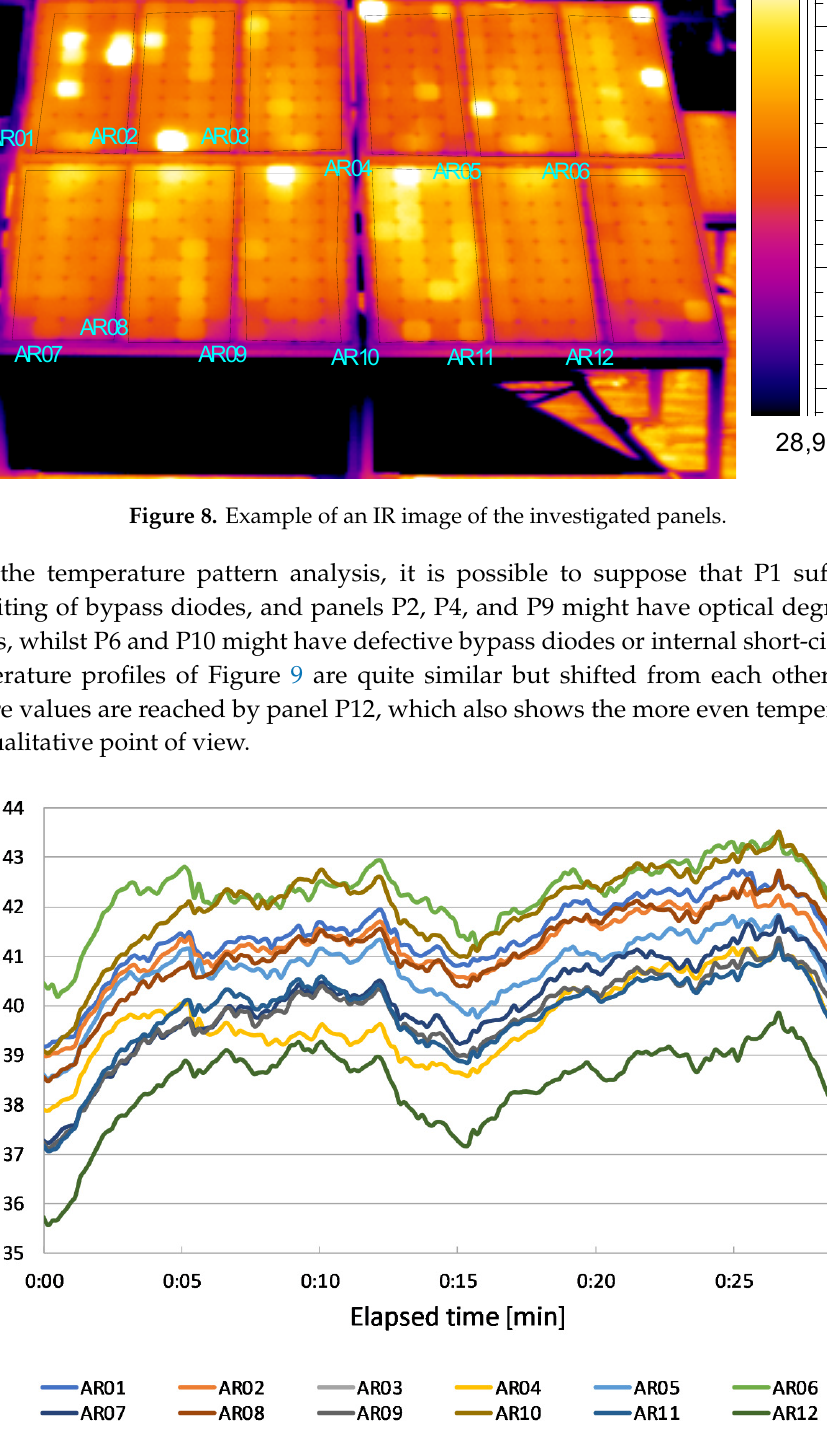
Figure 9. Panels’ temperature profiles during Test 1 (28th August).